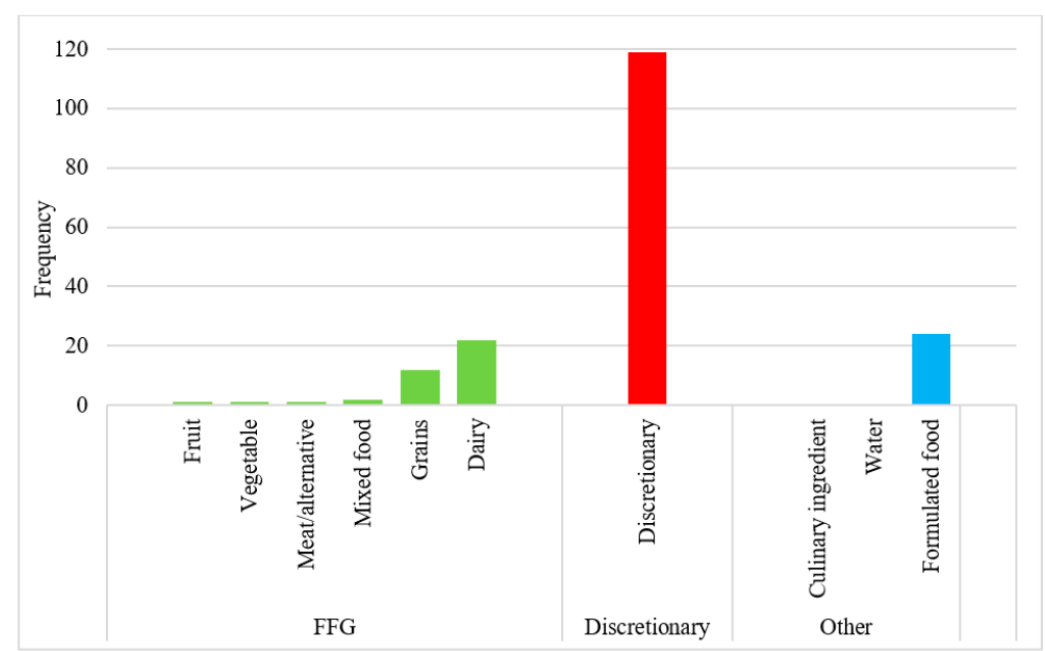
Figure 2. Frequency of sweetened HSR products by ADG category. FFG: Five Food Group